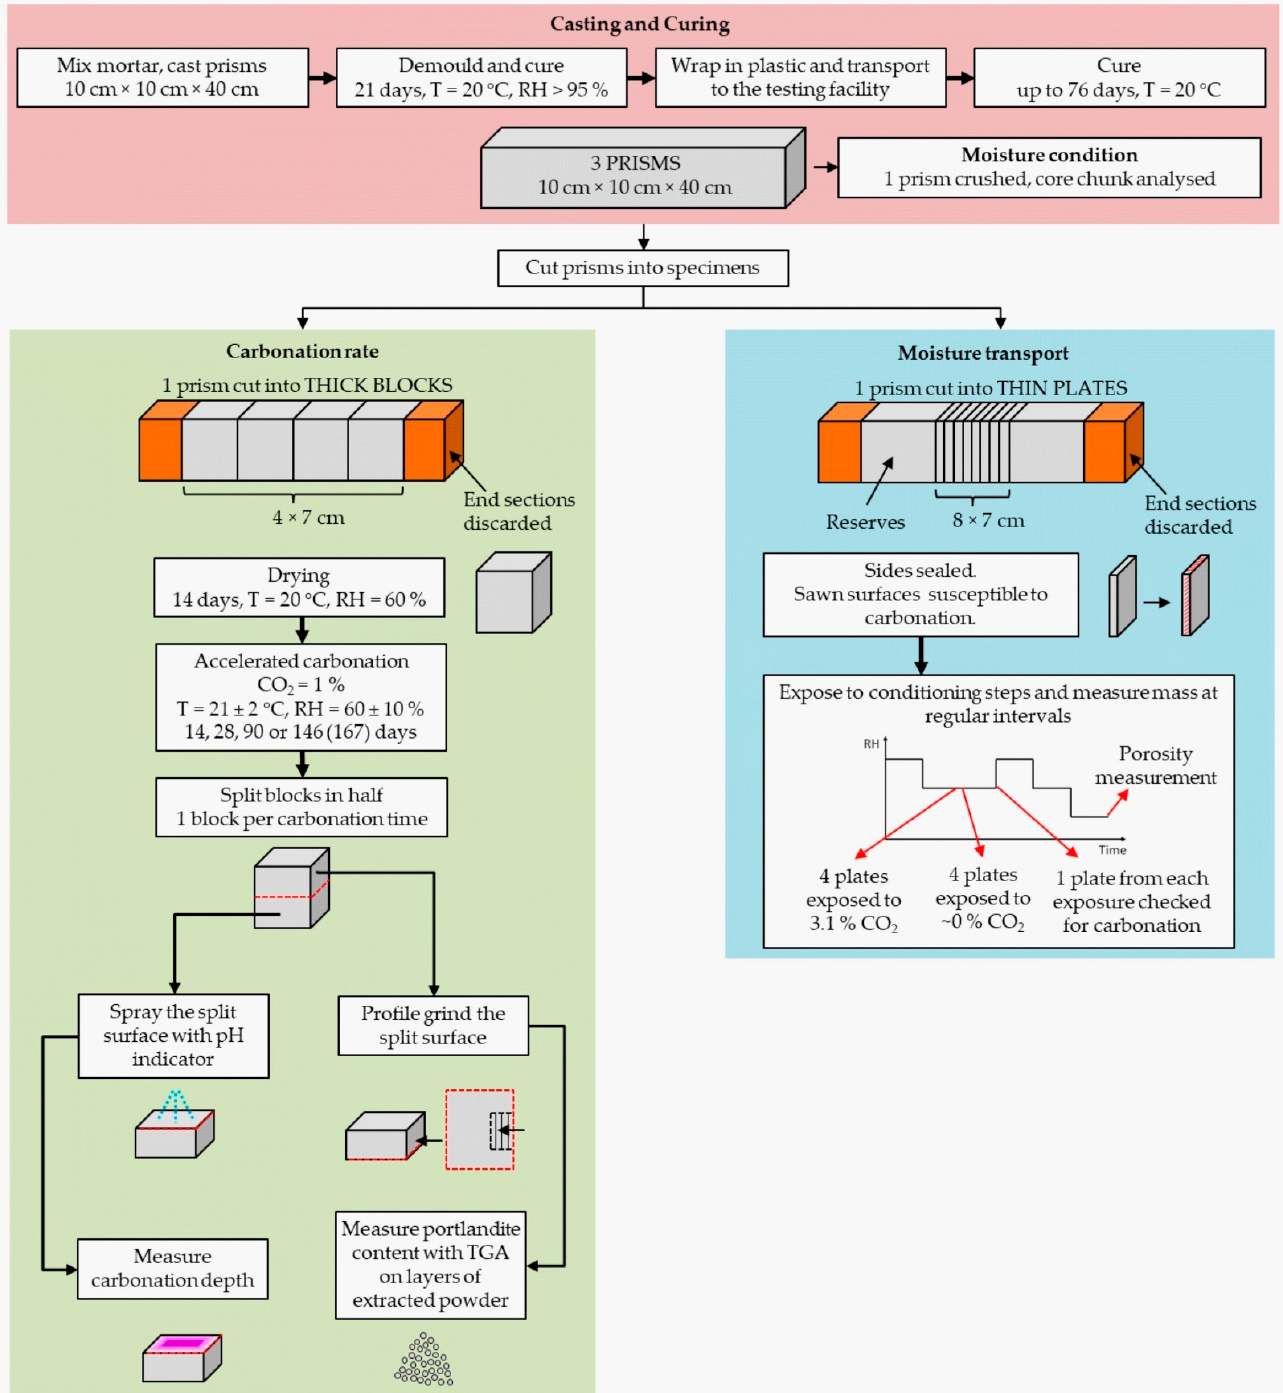
Figure 2. Flowchart showing the preparation, conditioning and testing of specimens. A detailed conditioning diagram for the moisture transport experiment is given in Figure 3.